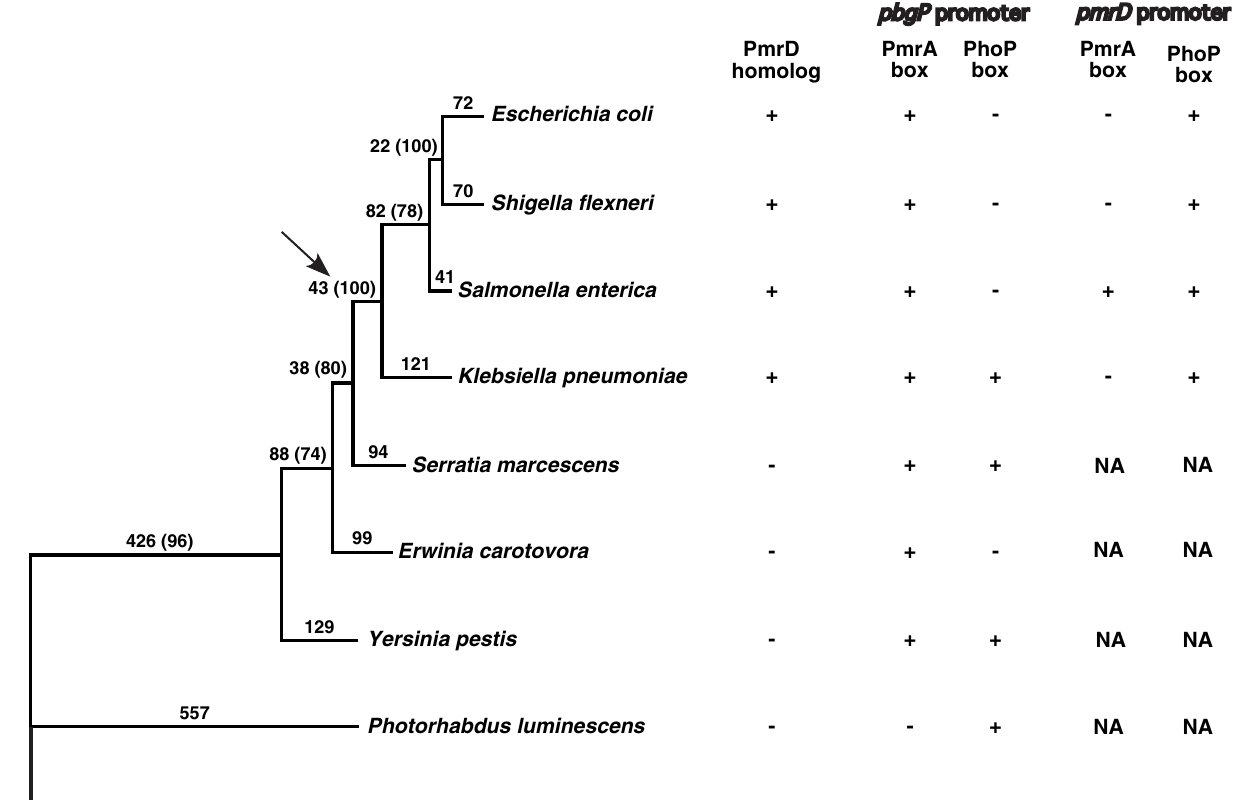
Pseudomonas aeruginosa Figure 2. Phylogenetic relationship of the analyzed bacterial species harboring the polymyxin B resistance pbgP operon. The phylogenetic tree was constructed as described in Materials and Methods. Numbers on the branches refer to branch lengths (which indicate the numbers of amino acid substitutions along the corresponding branches), and numbers in the parentheses represent bootstrap support (which indicates the percentage of the replicates from random resampling of the data where a particular node is found in the best tree). The solid arrow indicates the putative acquisition of the pmrD gene. The signs ‘‘ + ’’ or ‘‘ 2 ’’ denote, respectively, presence or absence of a protein ortholog or a transcription factor binding site. NA—not applicable.